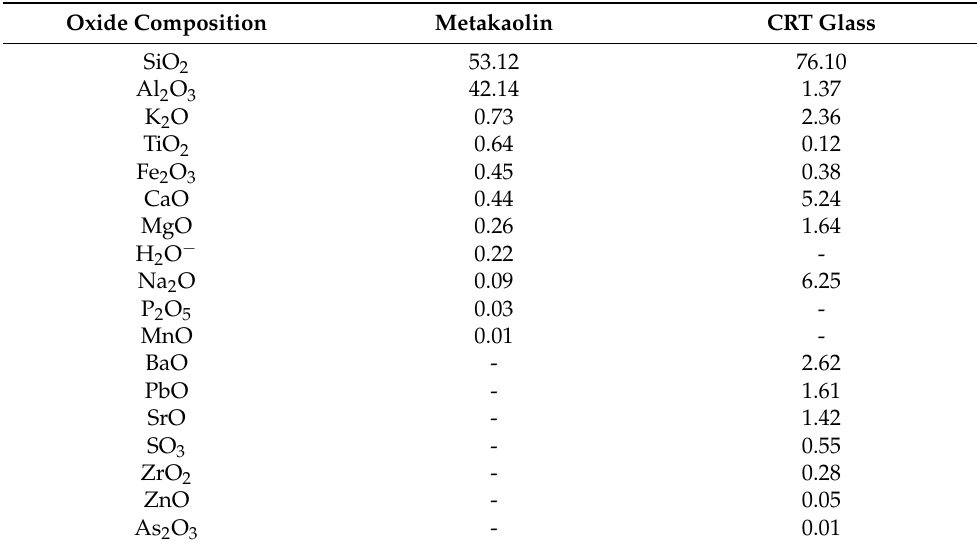
Table 1. Chemical composition (wt.%) of metakaolin 1 and CRT glass 2